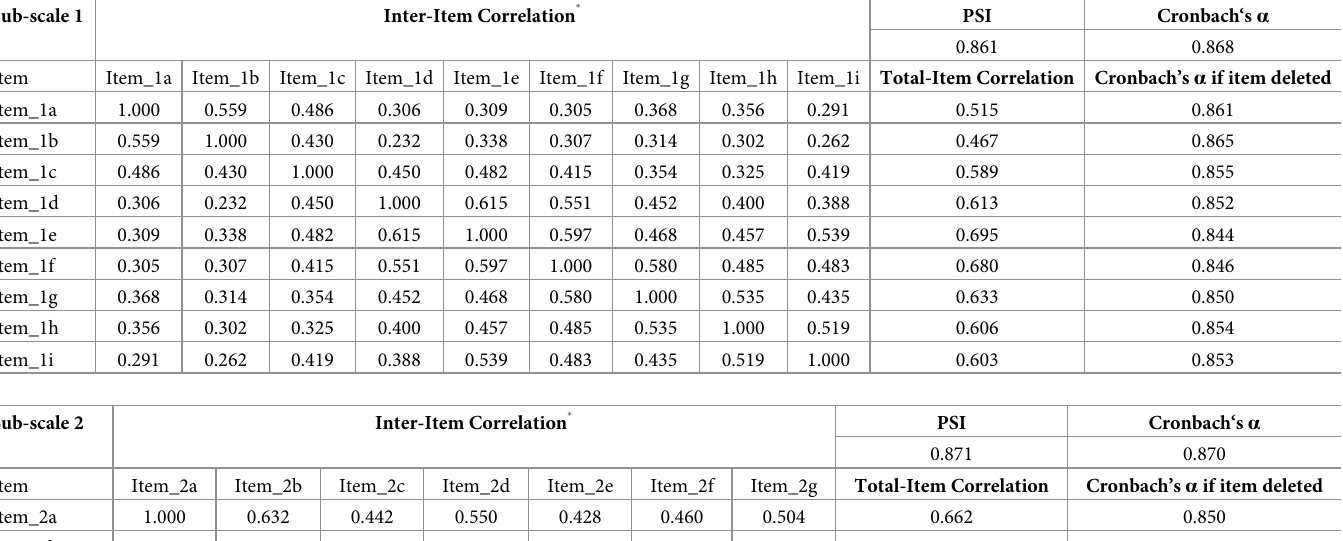
Table 6. Correlation analyses, PSI and Cronbach’s α